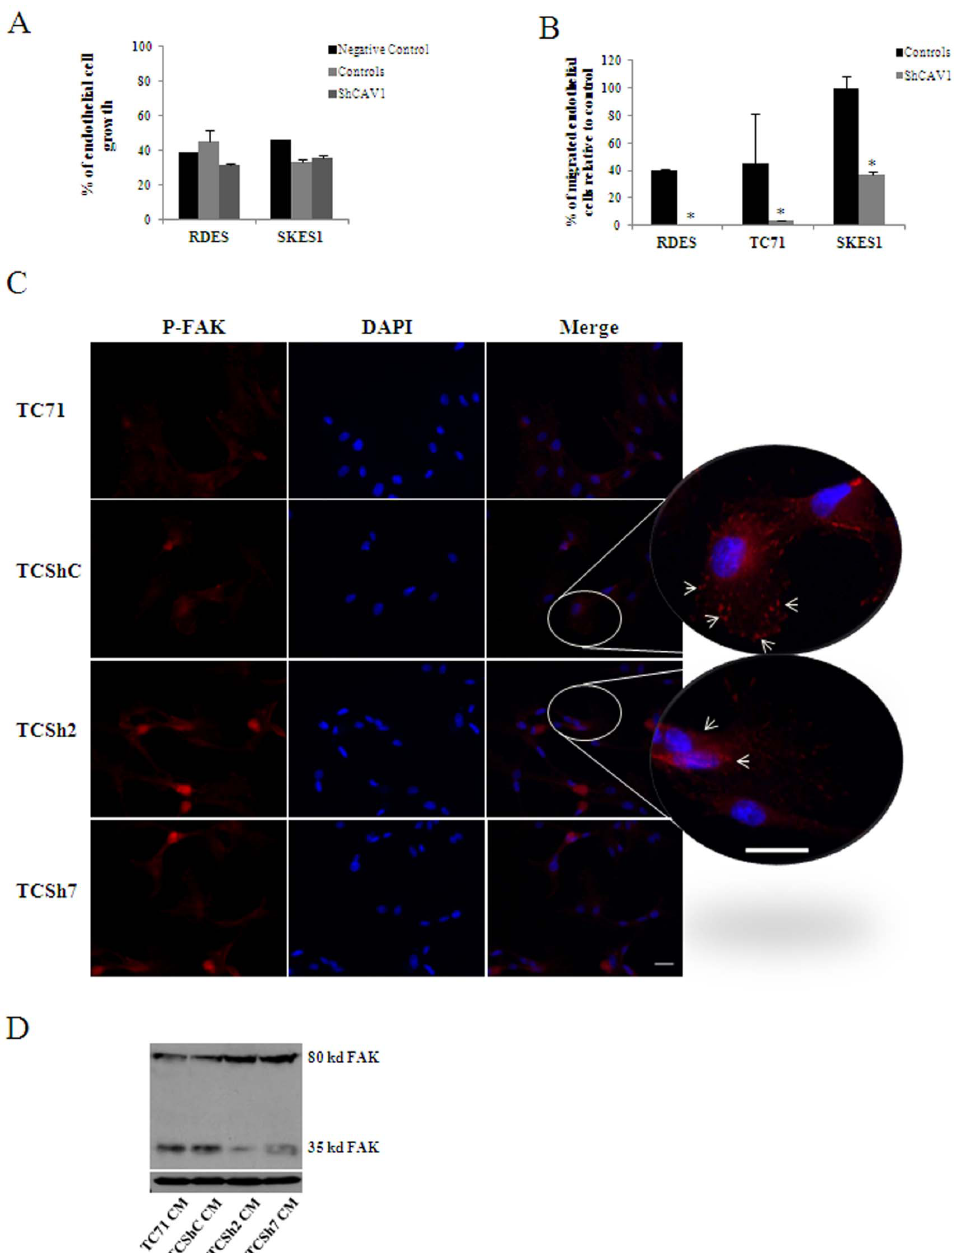
Figure 2. CAV1 silencing results on reduced endothelial cell migration. A. Quantification of endothelial cell growth comparing conditioned media (CM) from CAV1 knocked-down models versus RPMI without serum as negative control (n=3). B. Quantification of endothelial cell migration where CM from RDES and TC71 models was used as chemoattractant for endothelial cells; bars, SD (*P # 0.05 n=3) C. Phospho-FAK immunofluorescence. Endothelial cells cultured with CM from TC71 CAV1 knocked-down model, showing a decrease on phospho-FAK sprouts. Scale bar, 20 m m. D. FAK expression was analyzed in PAEC cells grown in CM from the TC71 model. Blot shows higher expression of 35 kd cleaved FAK form in cells grown with TC71 control CM than with TC71 Sh